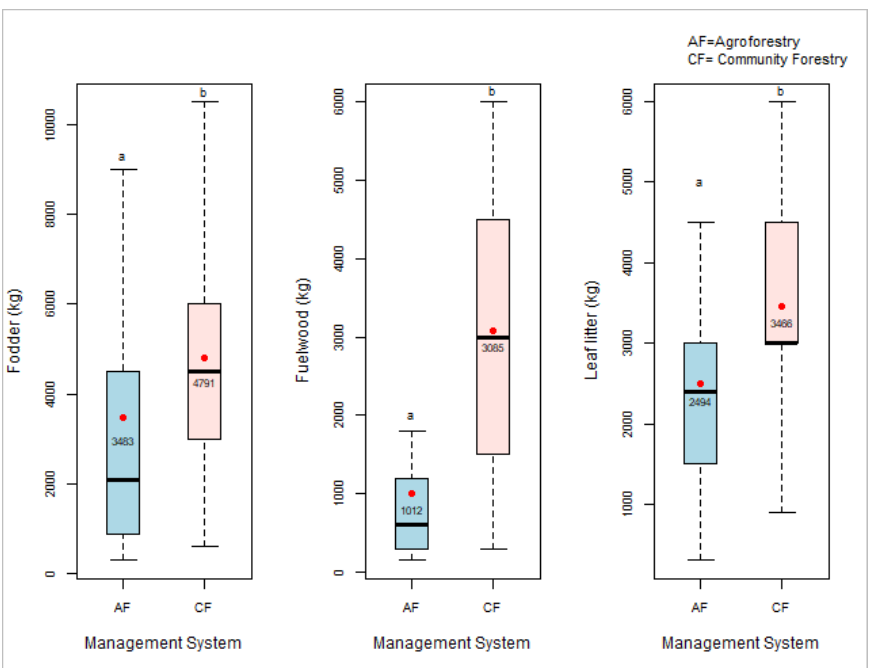
Figure 4. The average annual supply of forest products (fuelwood, fodder, leaf litter) from AF and CF systems where a red dot indicates the mean value while a black line indicates the median. The different letters (a and b) denotes the significance difference between the mean values.